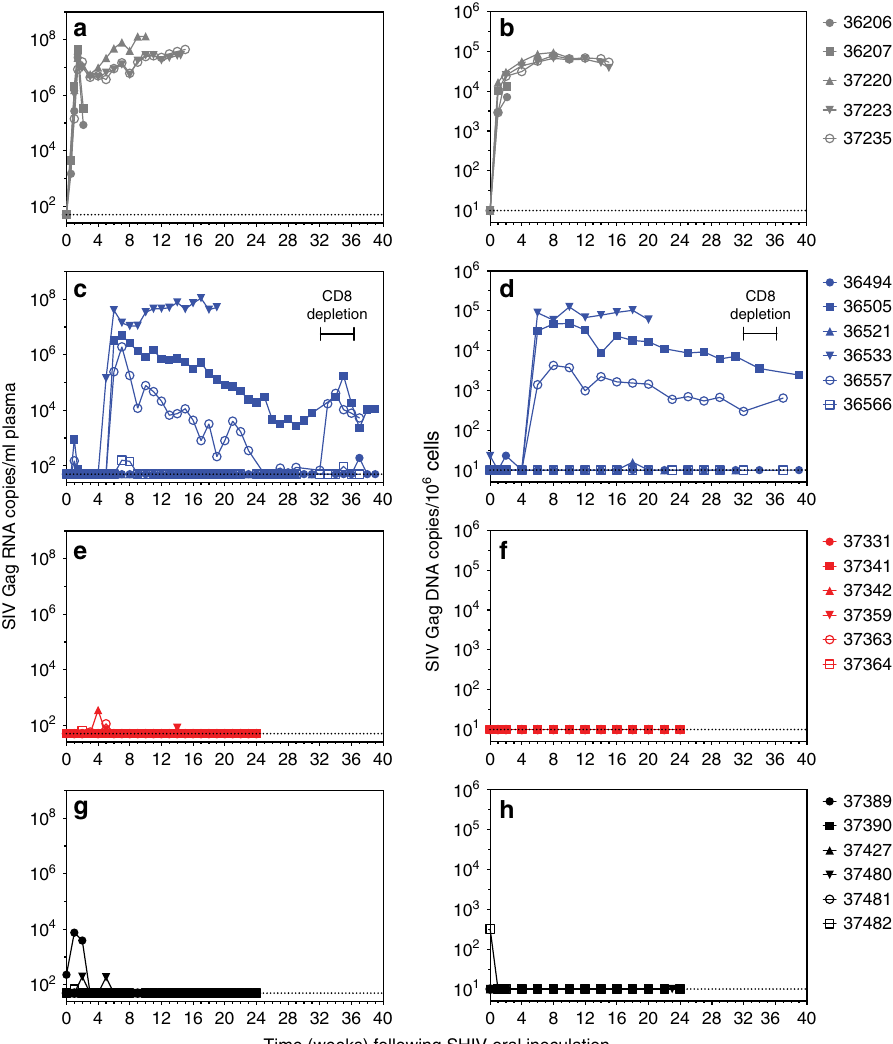
Fig. 2 Viremia is attenuated by bNAbs or ART post-exposure. Plasma viral loads ( a , c , e , g ) and PBMC-associated viral loads ( b , d , f , h ) were measured longitudinally. a , b Group 1 (untreated controls). c , d Group 2B (bNAbs at 48 h). CD8 α depletion was performed on two tight controllers (36494, 36566) and 2 viremic animals (36505, 36557) during the time frame indicated. e , f Group 3 (bNAbs at 30 h). g , h Group 4 (ART at 48 h). Group colors and individual animal symbols are consistent throughout the manuscript. Source data are provided as a Source Data fi